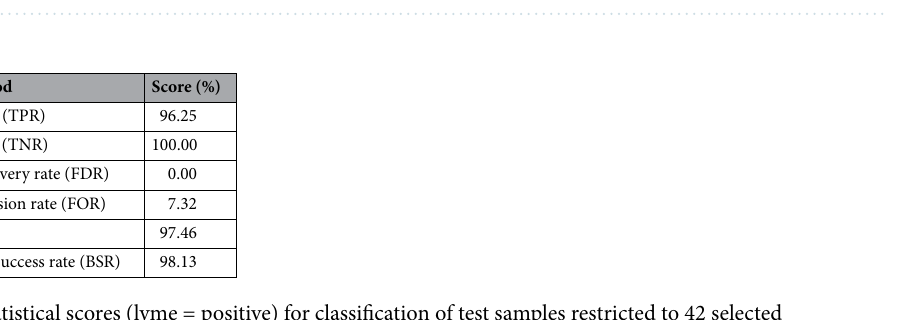
Table 3. Confusion matrix for classification of test samples restricted to 42 selected biomarkers with LCMS classifier using log normalized features.